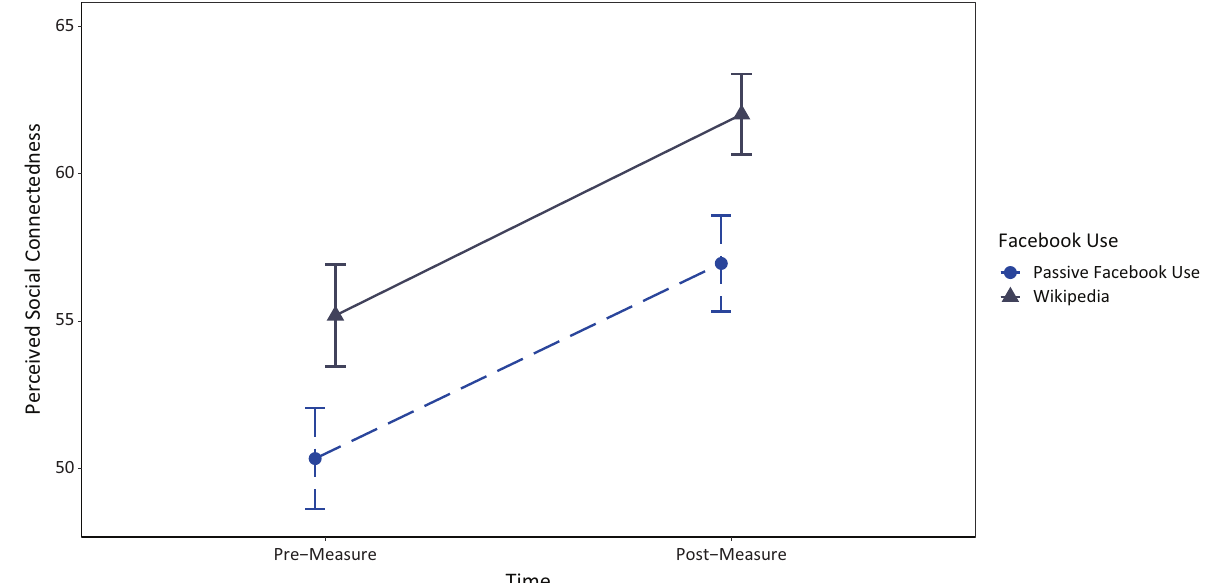
Figure 2. Mean Perceived Social Connectedness per Condition of Facebook Use Over Time for Experiment 2. Note: Standard errors are represented by error